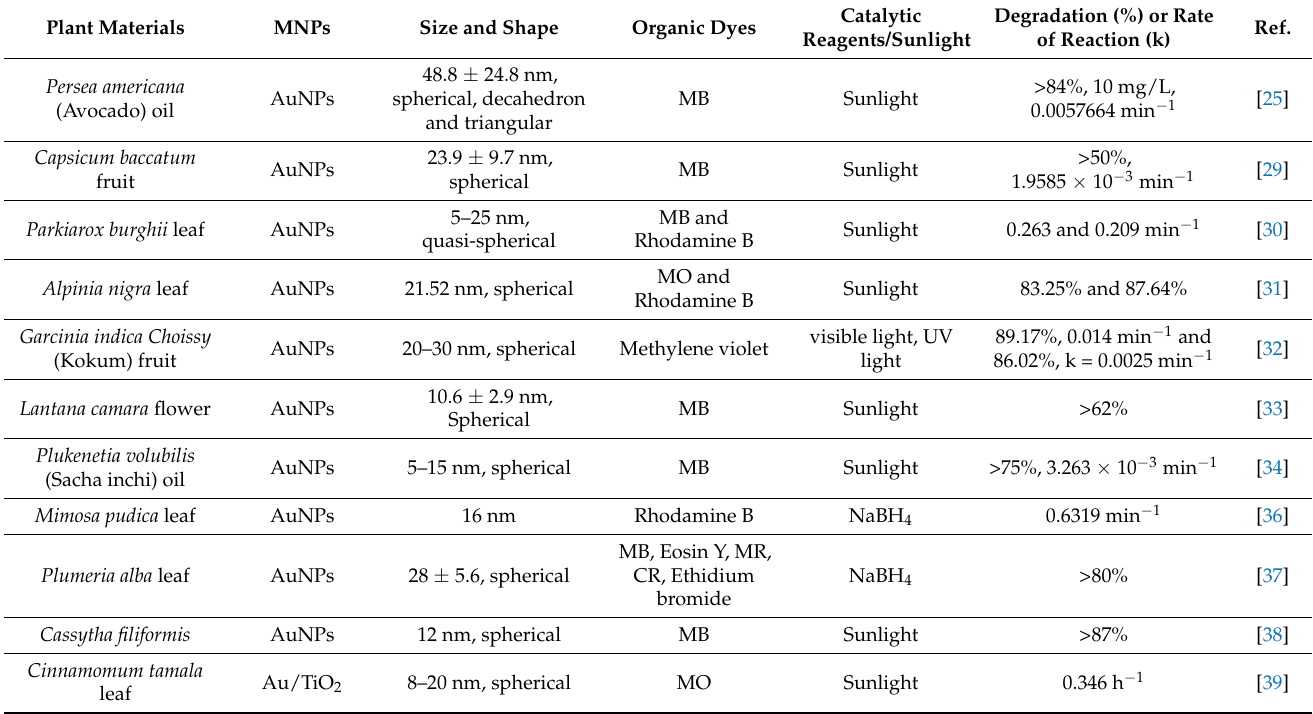
Table 1. Synthesis of gold nanoparticles using different plant extracts and its degradation